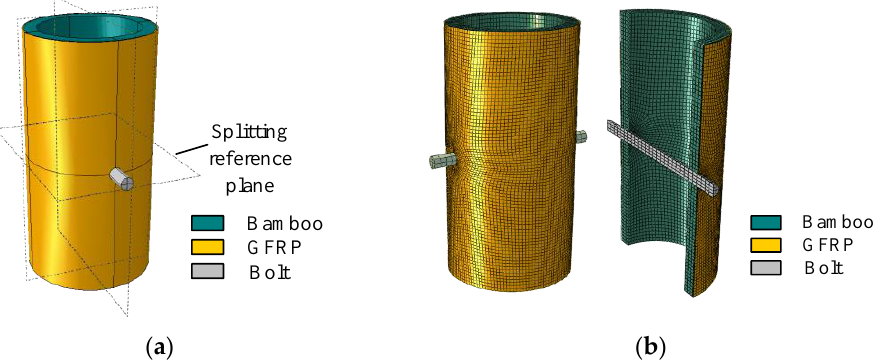
Figure 5. Division of the elements and components. ( a ) Simplified regional division; ( b ) Final element division.